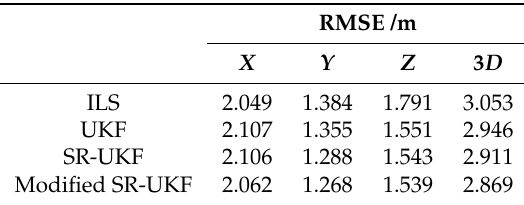
Table 5. Position estimation error using BDS/GPS’s